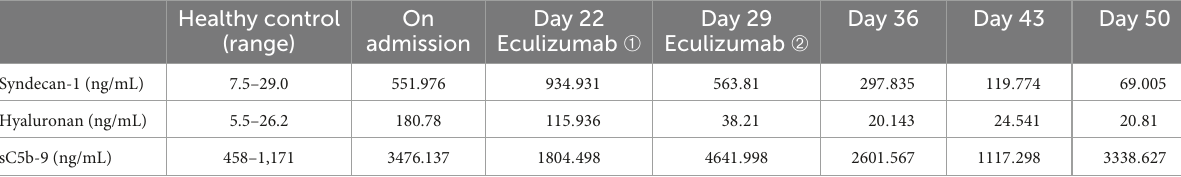
TABLE 2 Changes in syndecan-1, hyaluronan, and sC5b-9 levels before and after eculizumab